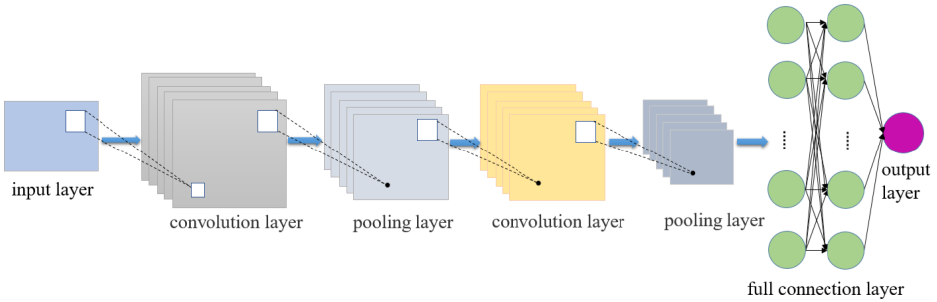
Figure 4. Structure of convolutional neural network diagram.